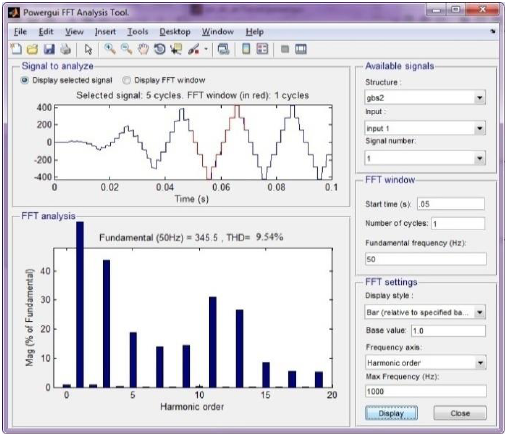
Figure 17 . THD for Modified 7-Level Inverter